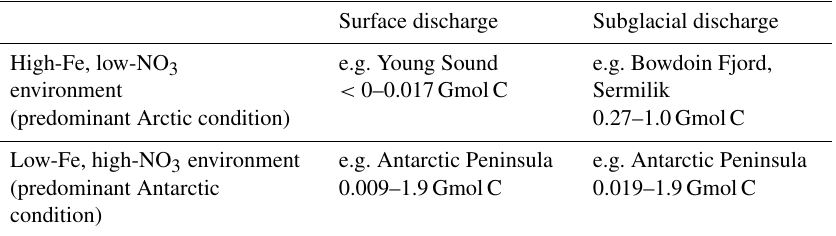
Table 5. Suppositional effect of different discharge scenarios calculated from the Redfield ratio 106 C : 16 N : 1 P : 0 . 005 Fe (Redfield, 1934; Twining and Baines, 2013). A steady freshwater discharge of 250m 3 s − 1 is either released from a land-terminating glacier or from a marine- terminating glacier at 100–250m depth, in both cases for two months into Fe-replete, NO 3 -deficient or Fe-deficient, NO 3 -replete marine environments. Freshwater endmembers are defined as 2µMNO 3 and 33–675nM dissolved Fe (Annett et al., 2017; Hodson et al., 2017; Hopwood et al., 2018). Ambient water column conditions are defined as Greenland (Achterberg et al., 2018) (i.e. high-Fe, low-NO 3 ) and Ross Sea (Marsay et al., 2017) (i.e. low-Fe, high-NO 3 ) shelf